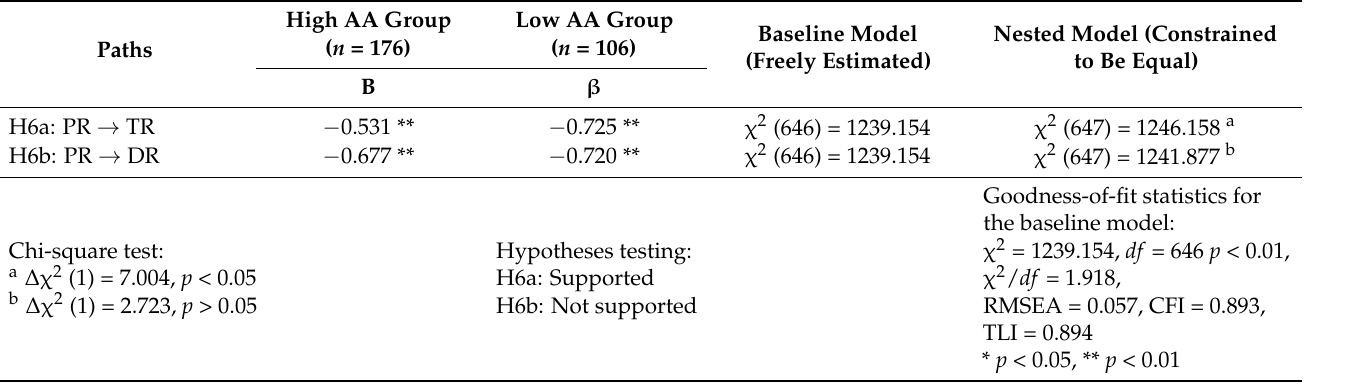
Table 3. Results of invariance test for structural models.